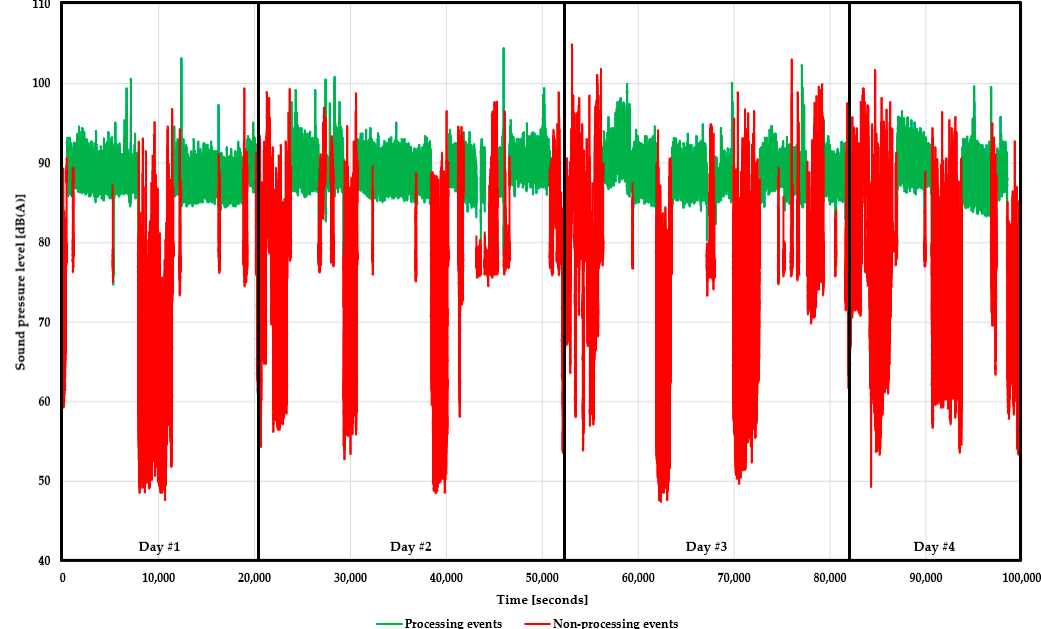
Figure 7. Variation of the sound pressure level ( SPL , dB(A)) in the time domain for the four observed days. Legend: red—non-processing events (time), green—processing events